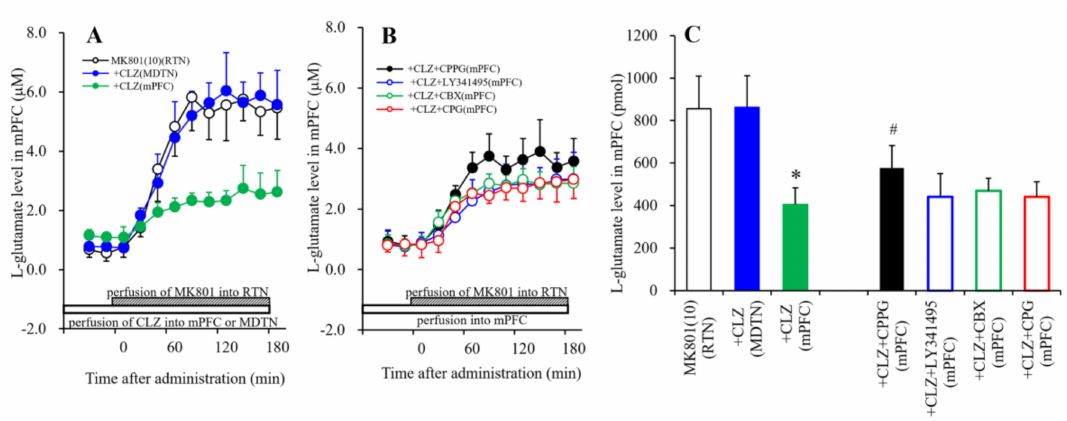
Figure 6. E ff ects of perfusion with therapeutically relevant concentration of CLZ (30 µ M) into the mPFC and MDTN on mPFC l -glutamate release induced by perfusion with MK801 (10 µ M) into the RTN ( A , B ). Perfusion medium in the mPFC or MDTN commenced with MRS containing CLZ. After confirming the stabilization of extracellular l -glutamate levels, the perfusate in the RTN was switched from MRS to MRS containing MK801 for 180 min. Interaction between perfusion with CLZ (30 µ M) and CPG (1 µ M), LY341495 (1 µ M), CPPG (100 µ M), or CBX (100 µ M) into the mPFC and its impact on mPFC l -glutamate release induced by perfusion with MK801 (10 µ M) into the RTN ( B , C ). Perfusion medium in the mPFC commenced with MRS containing CLZ with CPG, LY341495, CPPG, or CBX. After confirming the stabilization of extracellular l -glutamate levels, the perfusate in the RTN was switched from MRS to MRS containing MK801 for 180 min. Ordinates: mean ± SD ( n = 6) of extracellular l -glutamate level ( µ M). Abscissas: time after administration of MK801 perfusion (min). AUC values of l -glutamate level (pmol) during perfusion with MK801 (from 20 to 180 min) based on ( A , B ) were indicated in ( C ). * p < 0.05. This is relative to the control (MK801: opened bar) and # p < 0.05. This is relative to MK801 + CLZ (mPFC) (green bar) using LME with Tukey’s post hoc test.